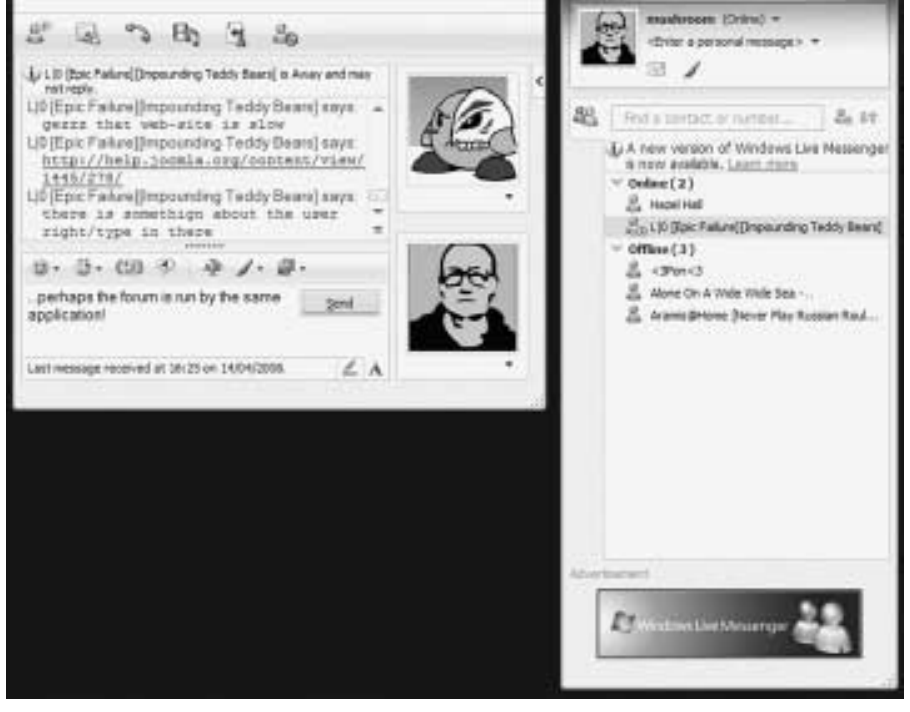
Figure 1. The two Messenger application